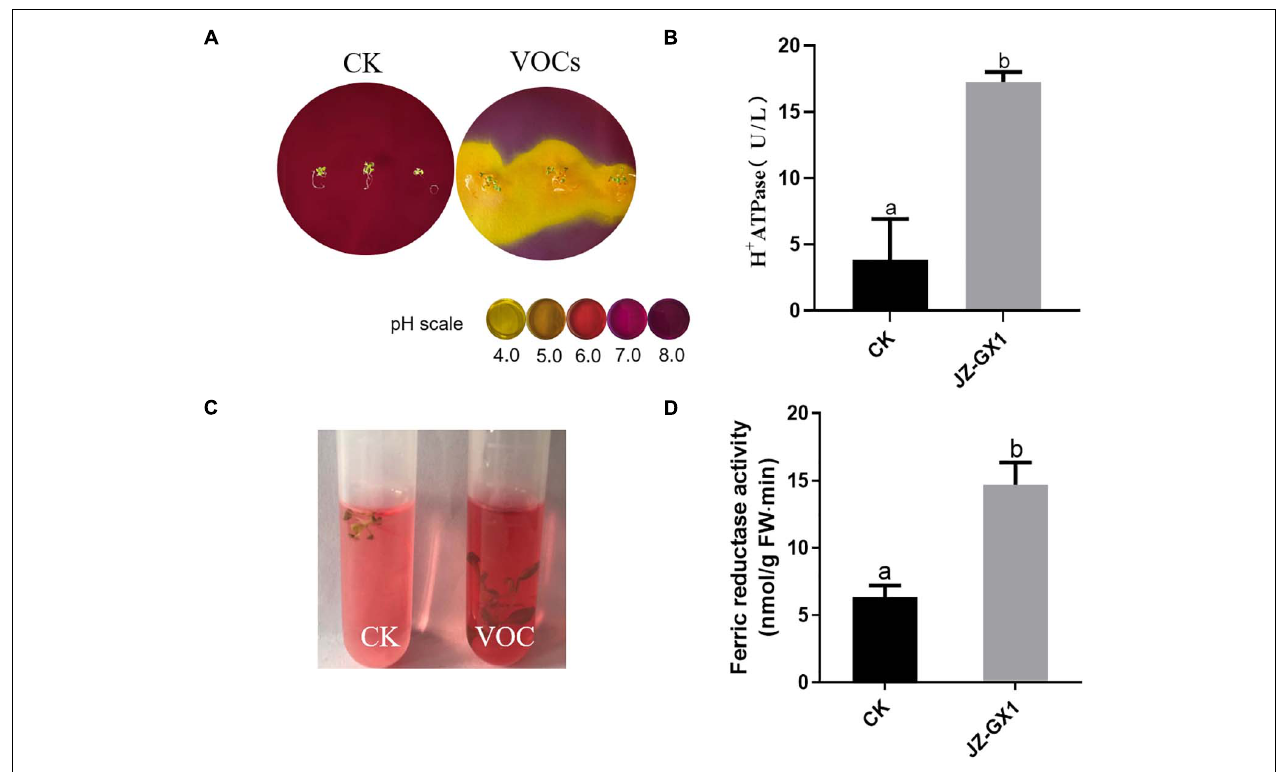
FIGURE 4 | Effects of VOCs from Rahnella aquatilis JZ-GX1 on H + ATPase and ferrate reductase activities in Arabidopsis thaliana . (A) H + secretion, (B) H + ATPase enzyme activity, (C) ferrate reductase reaction, and (D) quantitative analysis. CK: control. One-way ANOVA was performed, and Duncan’s post hoc test was applied. Different letters indicate statistically significant differences ( p < 0.05) among